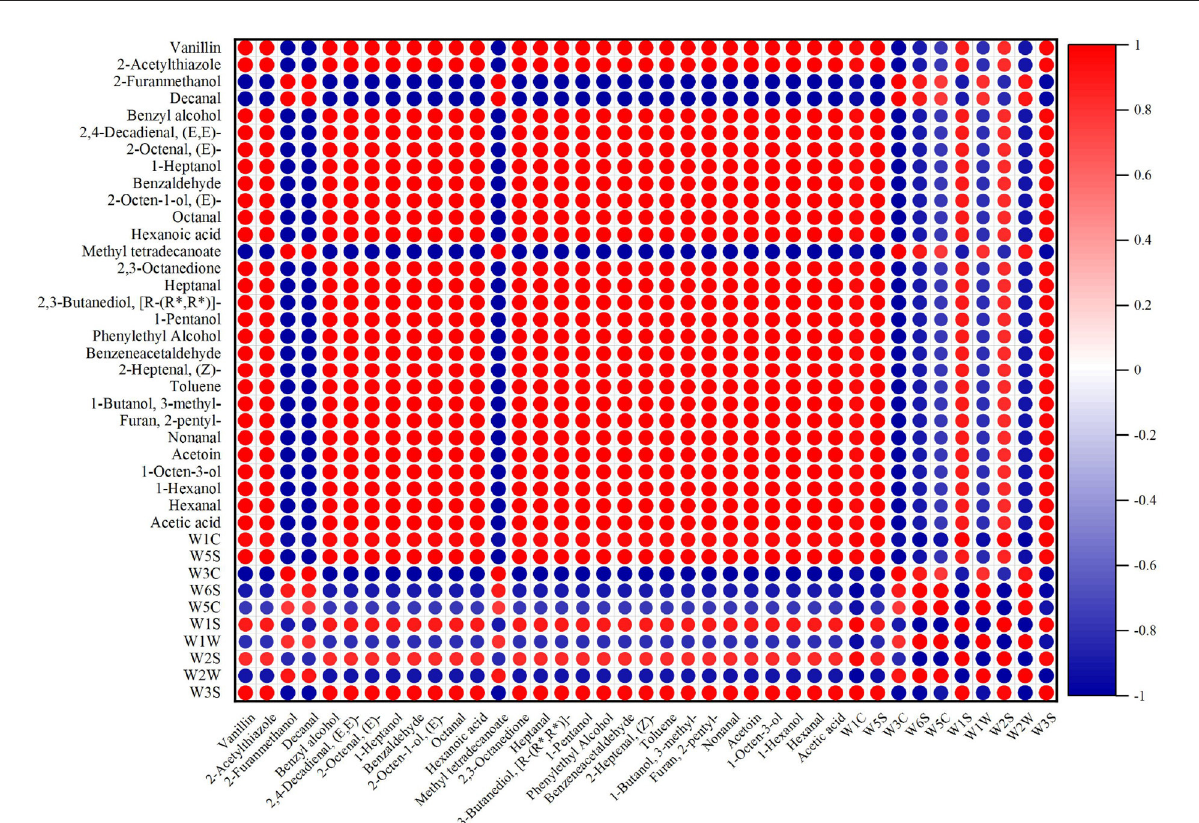
FIGURE9 Correlation analysis between E-nose and GC-MS of nian